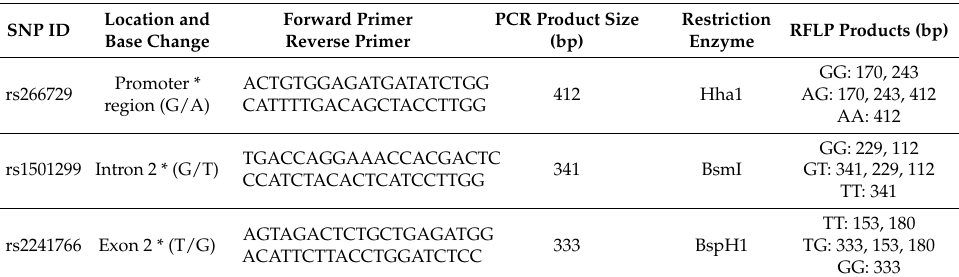
Table 1. ADIPOQ SNP information.